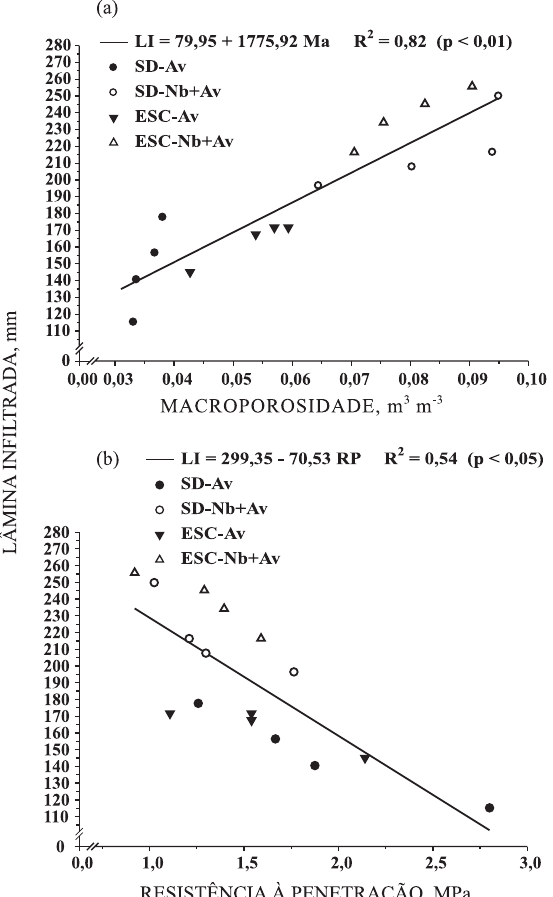
Figura 5. Relação entre macroporosidade na camada 0–0,20 m do solo e lâmina total de água infiltrada no solo (a) e resistência à penetração na camada 0–0,20 m do solo e lâmina total de água infiltrada no solo (b) de um Latossolo Vermelho distroférrico sob diferentes sistemas de manejo.